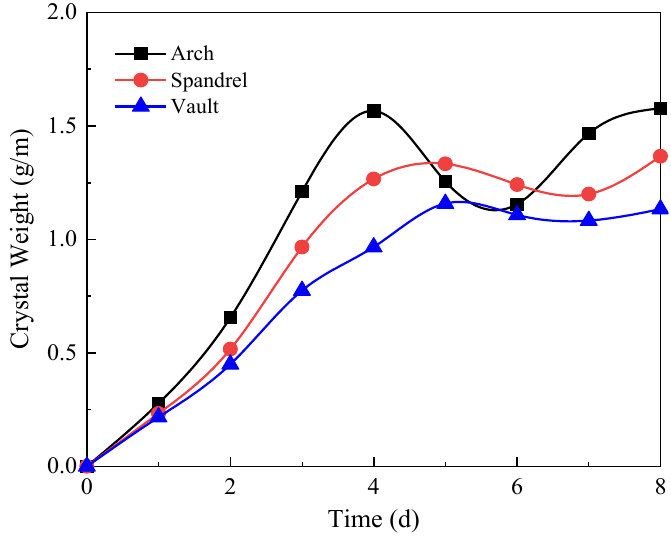
Figure 10. Crystal weight variation curve of circular drainage pipes.